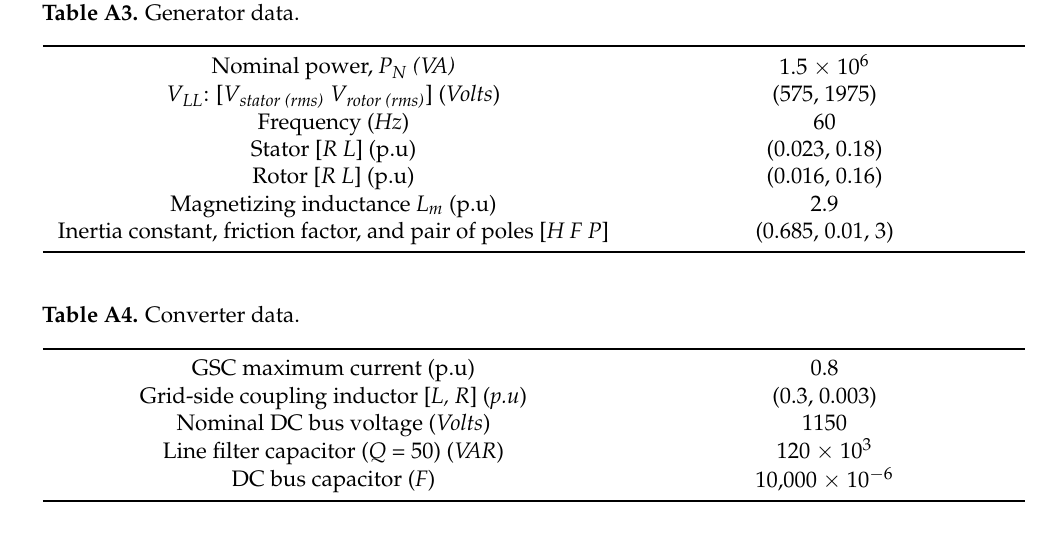
Table A5. Control parameters.